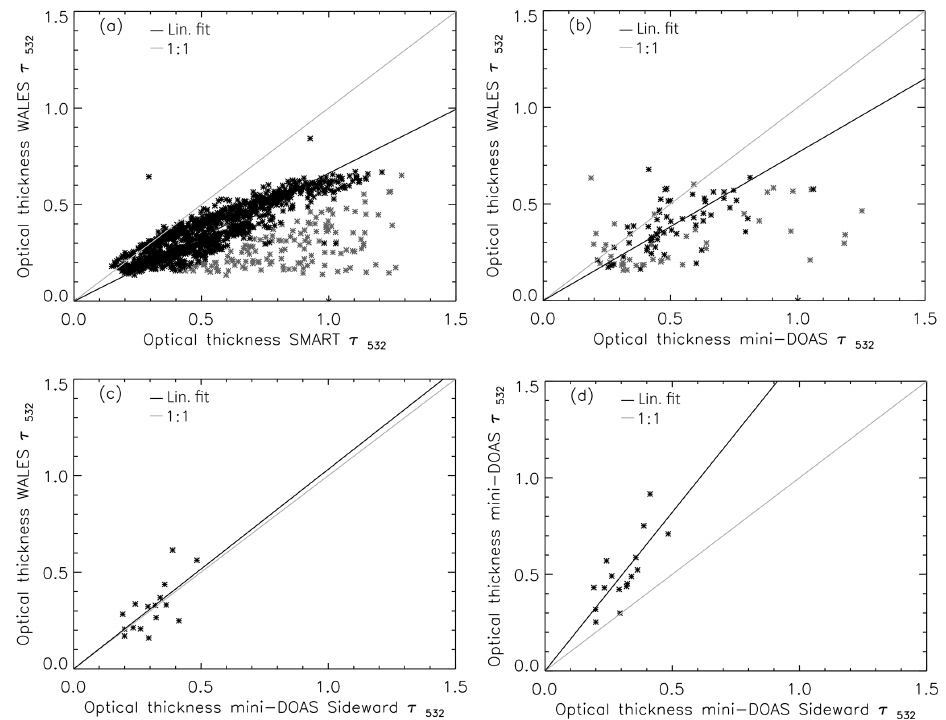
Figure 15. (a) Comparison of the retrieved cirrus optical thickness τ by WALES and SMART at λ = 532nm wavelength. (b) Comparison of the retrieved cirrus optical thickness τ by WALES and the mini-DOAS nadir channel at λ = 532nm wavelength. Measurements when a second cirrus layer was present are displayed in gray and are discarded in the regression. (c) Comparison of the retrieved cirrus optical thickness τ by WALES and mini-DOAS sideward viewing channels at λ = 532nm wavelength. No data are discarded. (d) Comparison of the retrieved cirrus optical thickness τ by mini-DOAS nadir and sideward viewing channels at λ = 532nm wavelength.